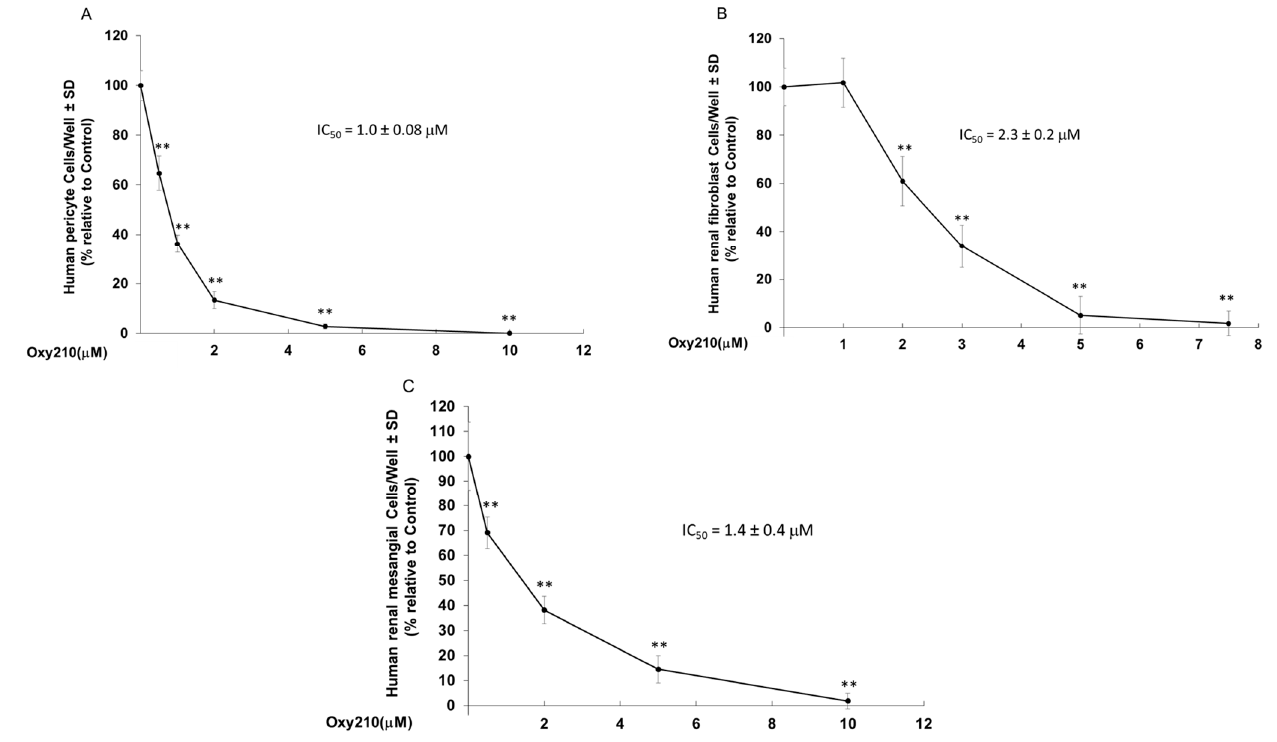
Figure 7. Oxy210 inhibits proliferation of human pericytes, renal fibroblasts, and renal mesangial cells . Human pericytes ( A ), human renal fibroblast cells ( B ) or human renal mesangial cells ( C ) were treated with Oxy210 as indicated in DMEM or RPMI containing 5% FBS, respectively, for 6 days and then were trypsinized and counted. Data from a representative experiment are reported as the mean of triplicate determinations ± SD (** p < 0.01 vs. control).